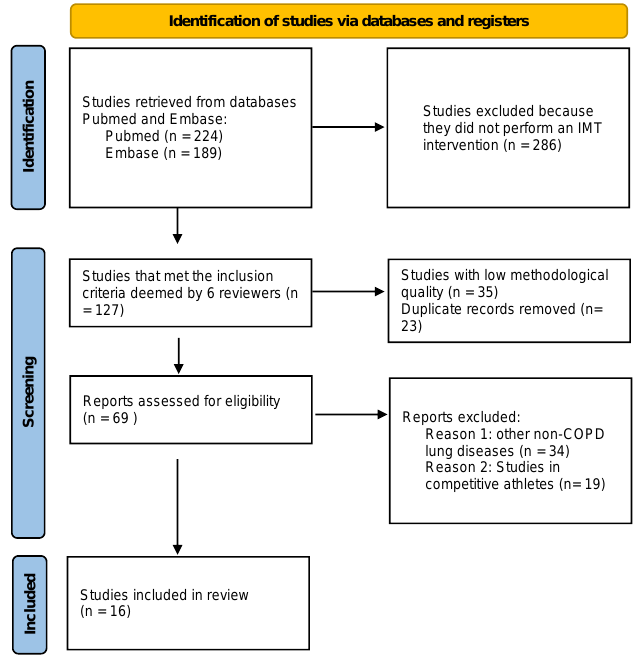
Figure 1. PRISMA 2020 flow diagram.